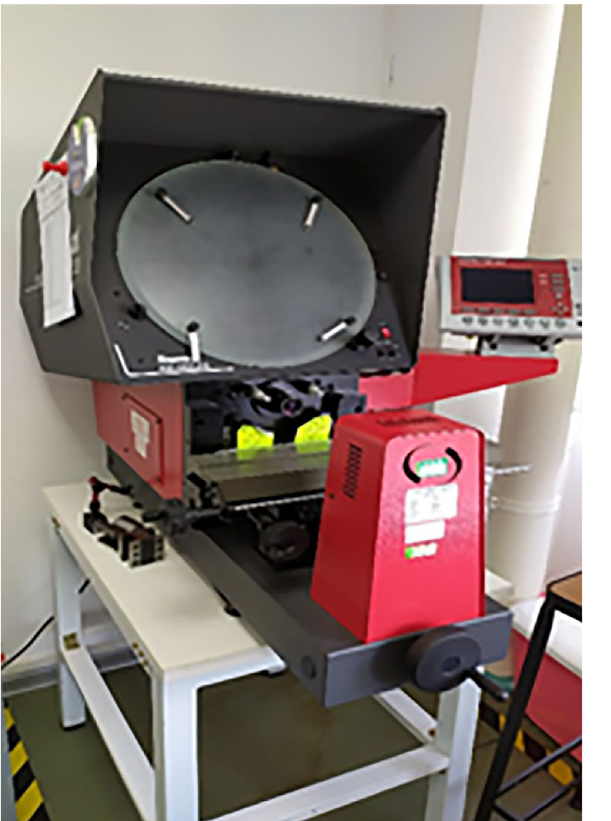
Figure 6. The profile projector (Starrett 400